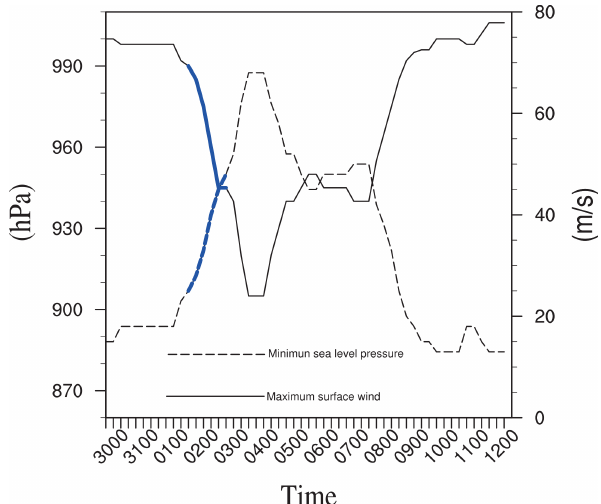
Figure 3. The time series of the minimum sea level pressure (solid line; unit: hPa) and the maximum surface wind (dashed line; unit: ms − 1 ) of Typhoon Soudelor from the CMA best-track data from 00:00UTC on 30 July to 06:00UTC on 12 August 2015. The specific period for the numerical results from 18:00UTC on 1 Au- gust to 06:00UTC on 4 August 2015 is highlighted in